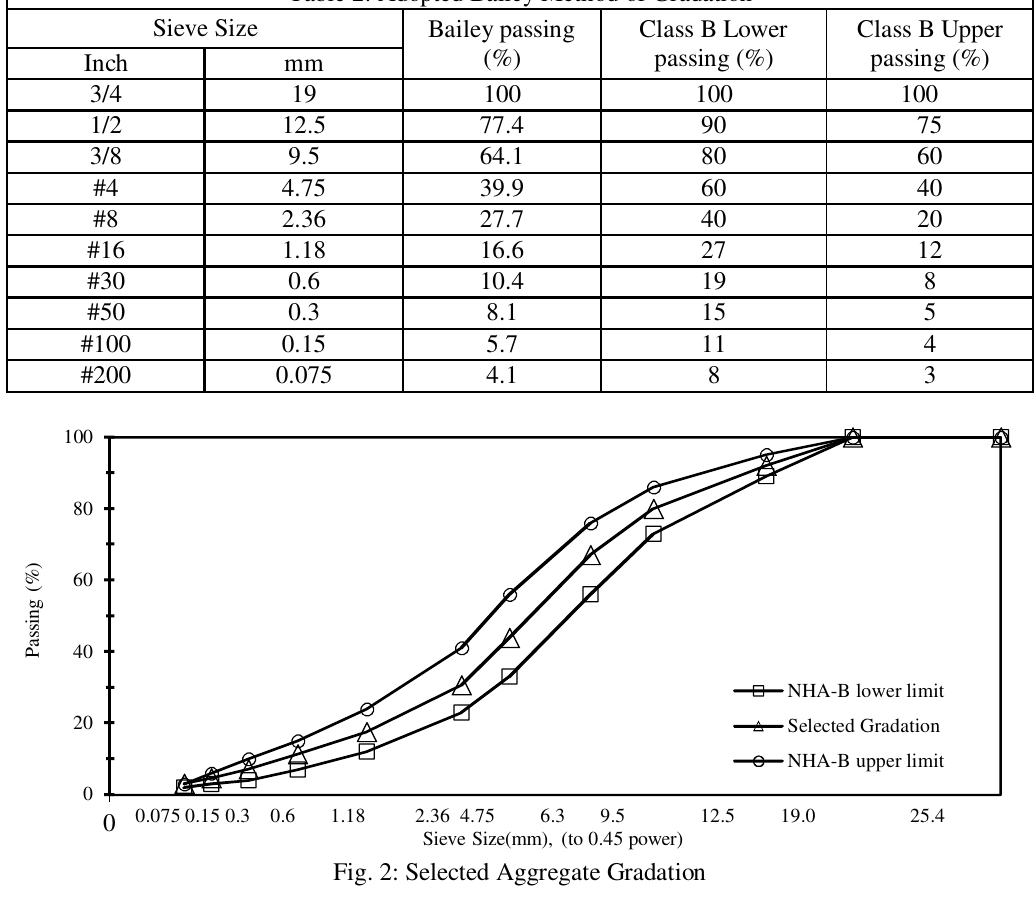
Table 2: Adopted Bailey Method of Gradation